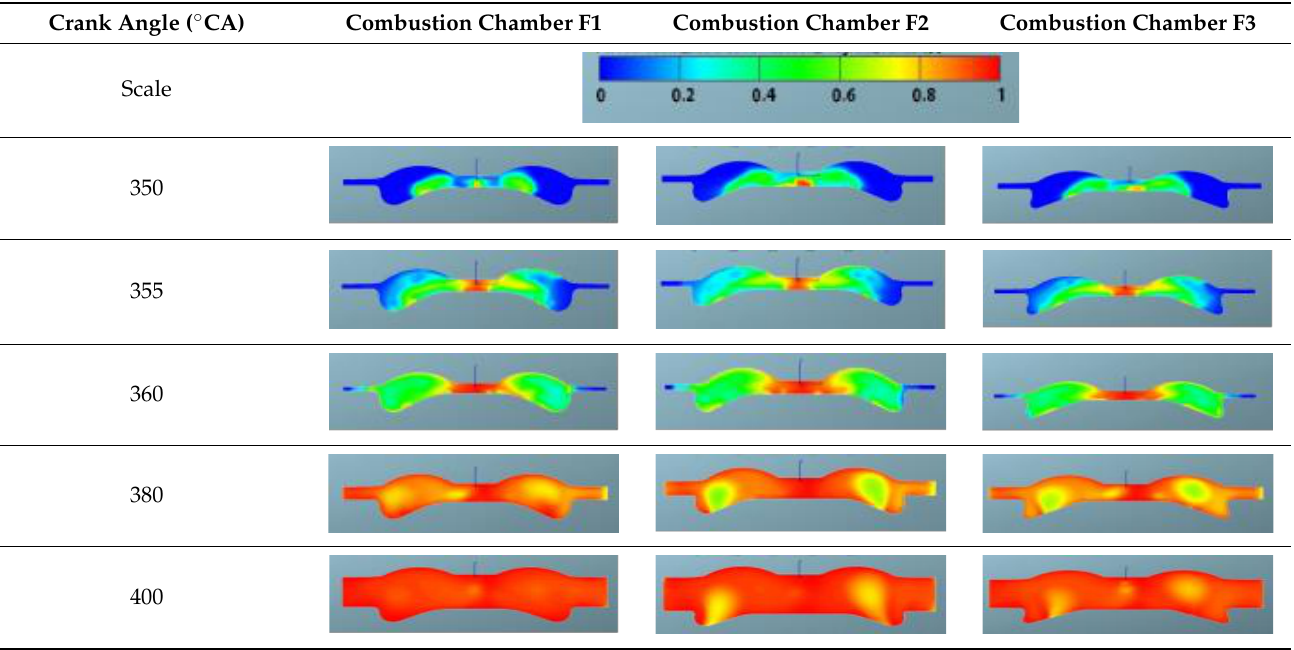
Table 16. Comparison of combustion reaction nephograms of the three combustion chambers with 160 ◦ spray angle injector.